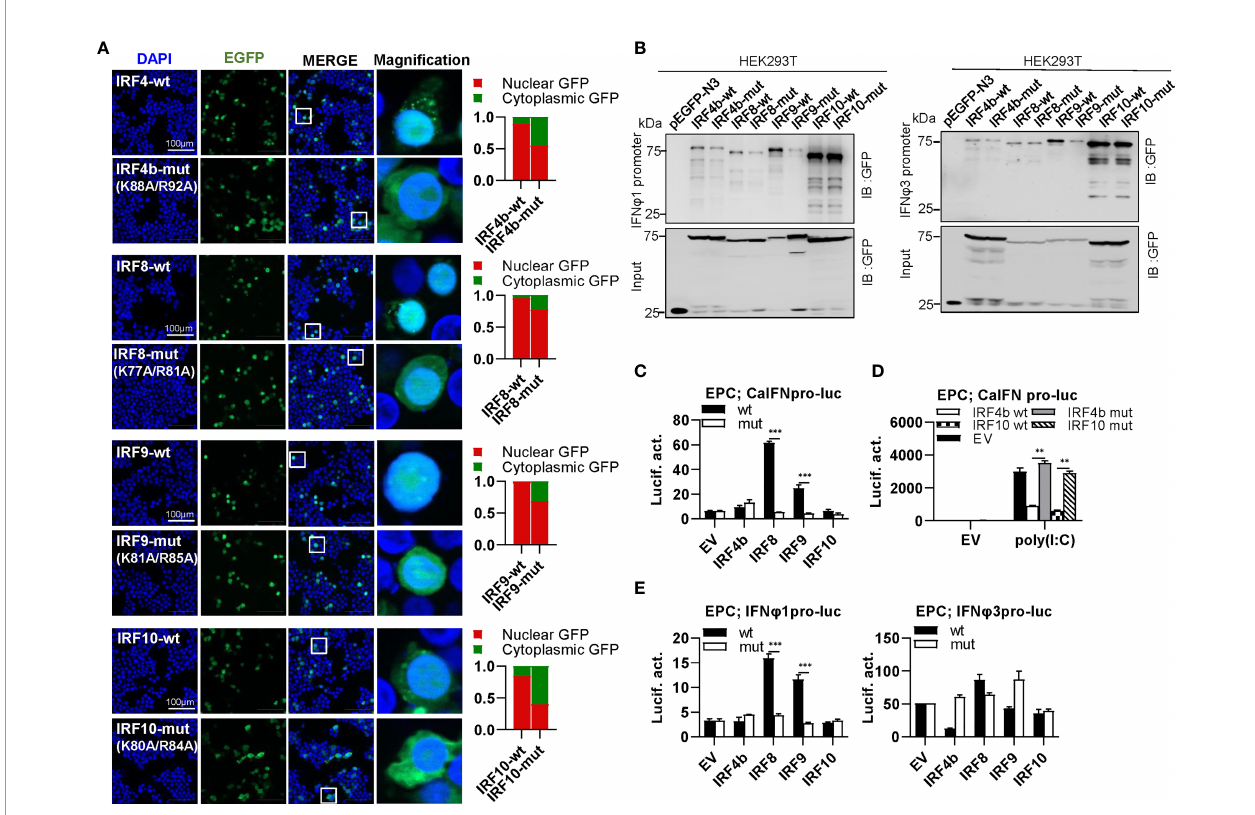
FIGURE 9 | The two basic residues are essential for IRF4b/8/9/10 to regulate IFN response. (A) Mutation of the two basic residues impaired the constitutively nuclear accumulation of IRF4b/8/9/10. Left panels: HEK293T cells seeded overnight on microscope slide cover-glasses in six-well plates were transiently transfected as in Figure 4 , with indicated plasmids (2 m g each) for 24h, followed by confocal microscopy examination. The last column showed magni fi cation view of the area highlighted in the box. Right panels: The intensities of nucleus/cytoplasm GFP were quantitated using the ImageJ processing program and normalized to that of the empty construct pEGFP-N3, which was set to 1:1. (B) Pull-down analysis of the binding af fi nity of wild types and mutants of IRF4b/8/9/10 to IFN j 1/IFN j 3 promoters. DNA pull-down assays were performed as in Figure 3B , by incubating biotin-labeled IFN j 1 or IFN j 3 promoter DNAs with appropriate amounts of HEK293T cell lysates, where cells were transfected for 30h with wild types or mutants of IRF4b/8/9/10, respectively. (C) IRF8/9 mutants failed to stimulate the activation of crucian carp IFN promoter. EPC cells seeded in 48-well plates overnight were transfected for 30h with CaIFNpro-luc, together with the indicated IRF plasmids (100ng each). (D) IRF4b/10 mutant failed to inhibit poly(I:C)-triggered activation of crucian carp IFN promoter. EPC cells were transfected with the indicated plasmids (100ng each), together with poly(I:C) (1 m g/ml) for 30h. (E) IRF8/9 mutants failed to stimulate the activation of zebra fi sh IFN j 1/IFN j 3 promoters. EPC cells were transfected with IFN j 1pro-luc or IFN j 3pro-luc, together with the indicated IRF plasmids (100ng each). 30 h later, cells were harvested for luciferase assays. (***P < 0.001, **P <